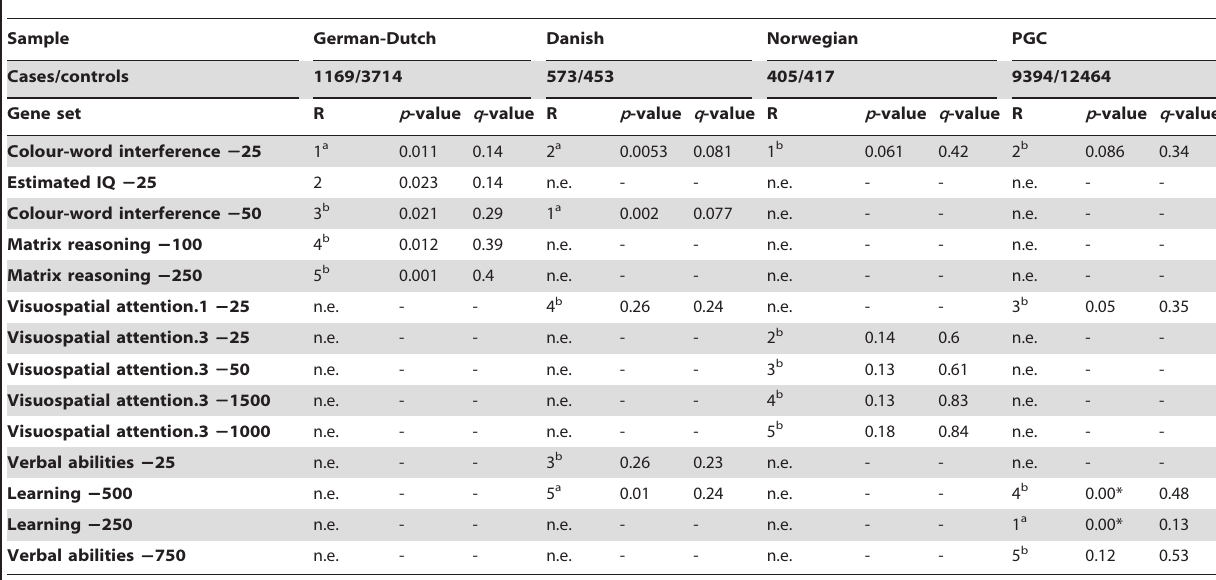
Table 3. Testing gene sets associated with normal neurocognitive variation for enrichment of association with schizophrenia.